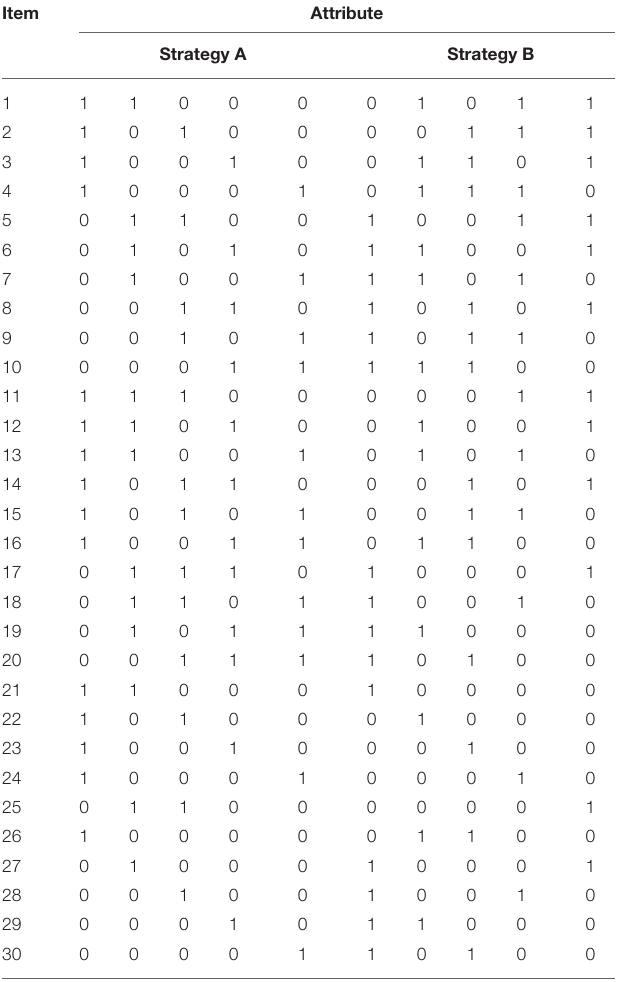
TABLE 2 | The Q matrix design in simulation 2. TABLE 3 | Evaluating the accuracy of the item parameters based on different numbers of items in simulation study